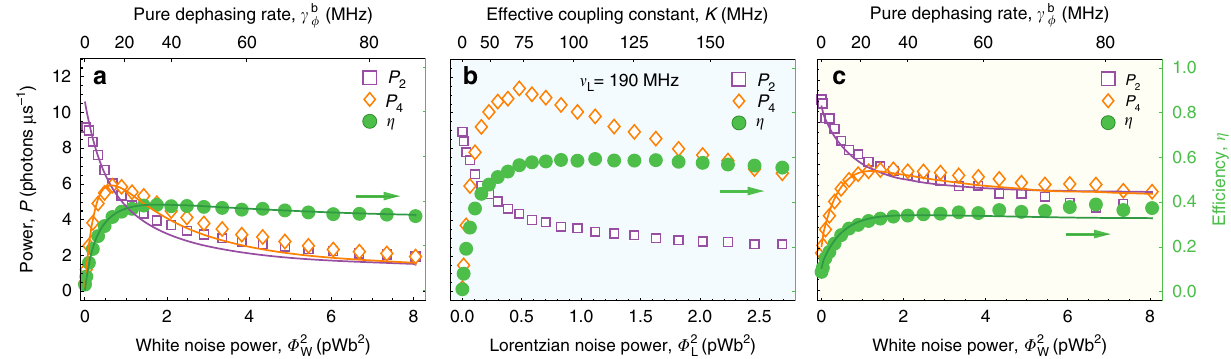
Fig. 4 Total extracted power P 4 , re-emitted power P 2 , and transport ef fi ciency η for a coherent excitation and white noise environments, b coherent excitation and Lorentzian noise environments, and c incoherent excitation and white noise environments. Data are plotted as a function of white noise power Φ 2 or equivalently bright state dephasing rate γ b ϕ for a and c and as a function of Lorentzian noise power Φ 2 W environment coupling constant K for b . Solid lines are results of master equation simulations (see Supplementary